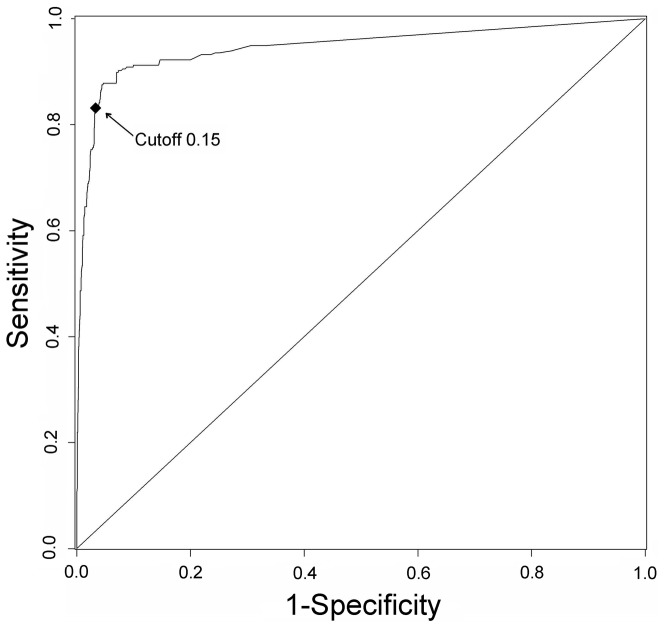
ROC curve of cross-organism validating for Ecol.Black diamond denotes the default cutoff of 0.15.